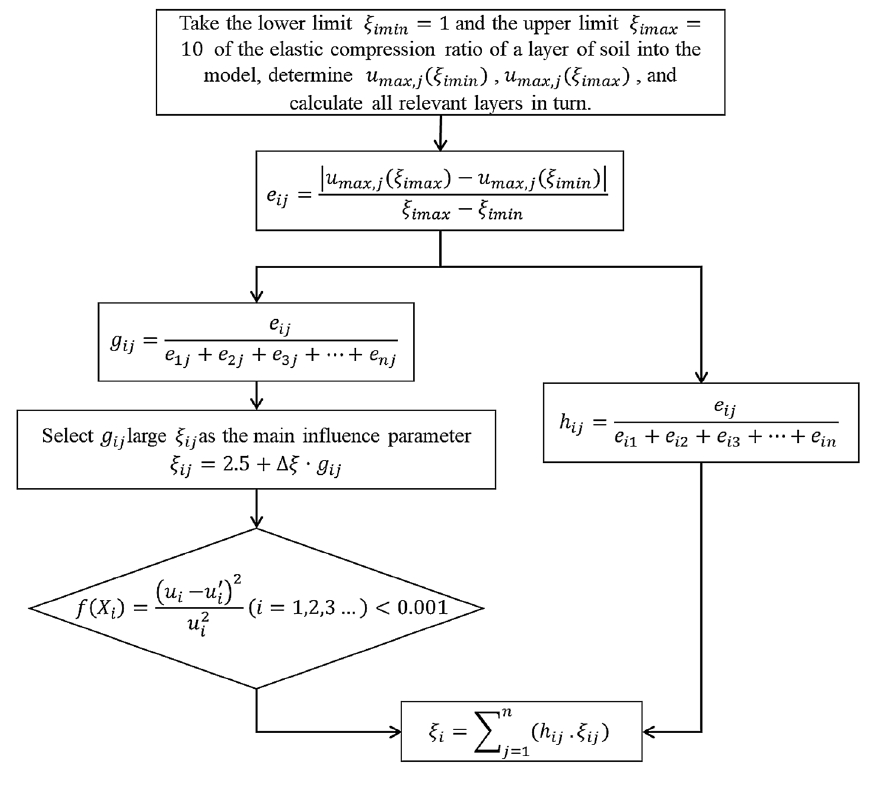
Figure 1. Inversion calculation flow